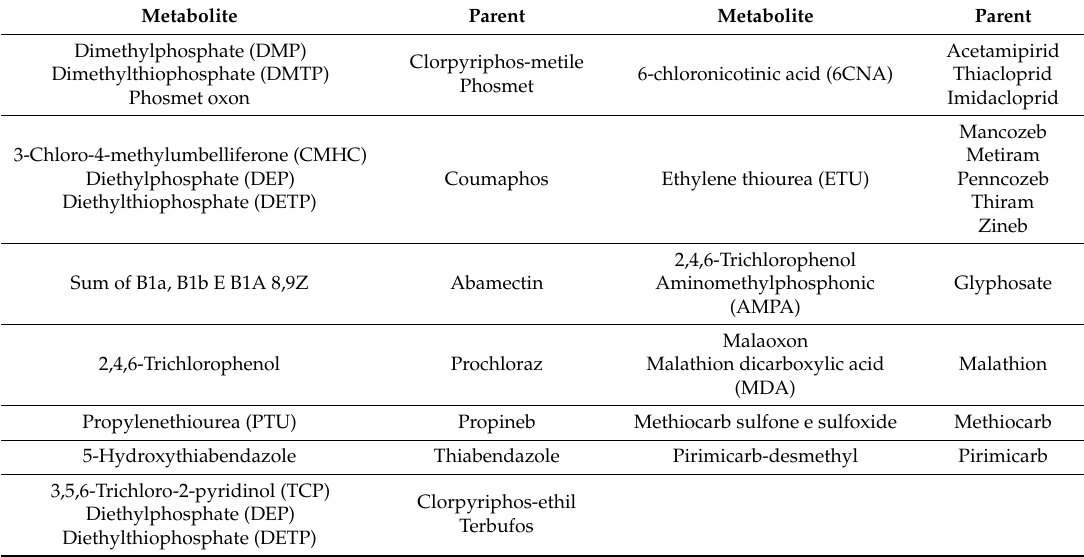
Table 2. Metabolite and parent pesticides analysed in urine